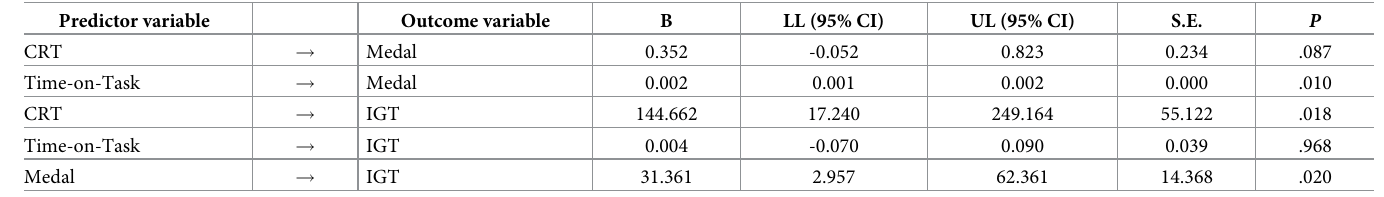
Table 3. Regression weights in the model that included Medal, cognitive reflection task (CRT), and Time-on-task as predictors of performance in Iowa Gambling Task (IGT). Bootstrapped estimates were used to determine standard error, confidence intervals, and p-values. Predictor variable